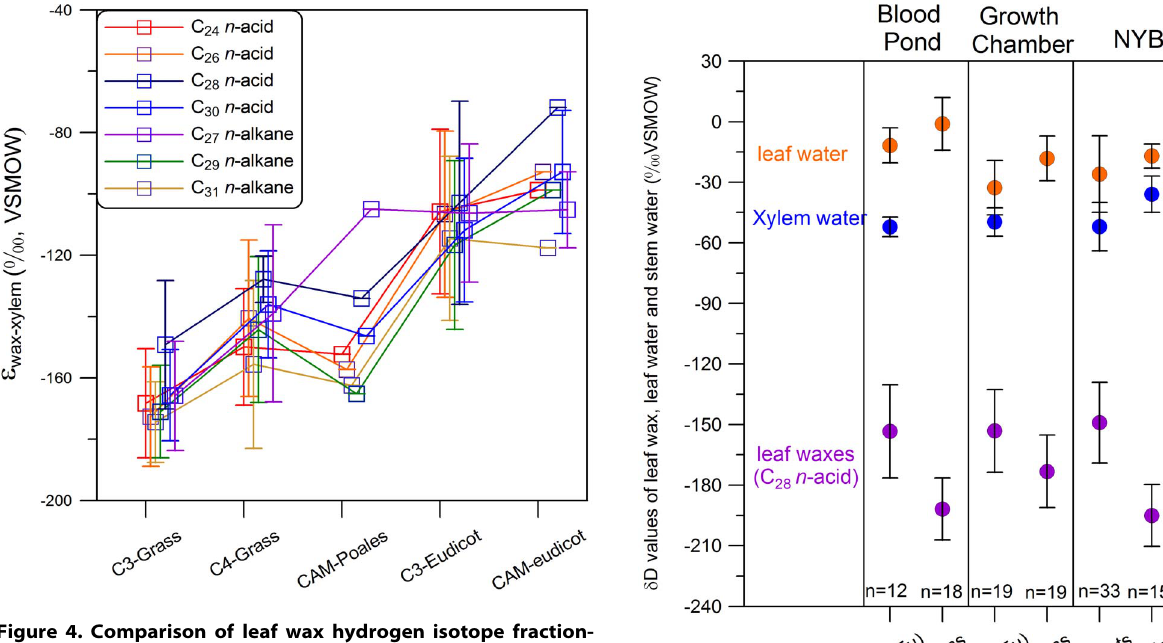
Figure 4. Comparison of leaf wax hydrogen isotope fraction- ation values relative to xylem water in different phylogenetic lineages with different photosynthetic pathways. The error bars show the 1 s standard deviation for all the species in individual lineages.